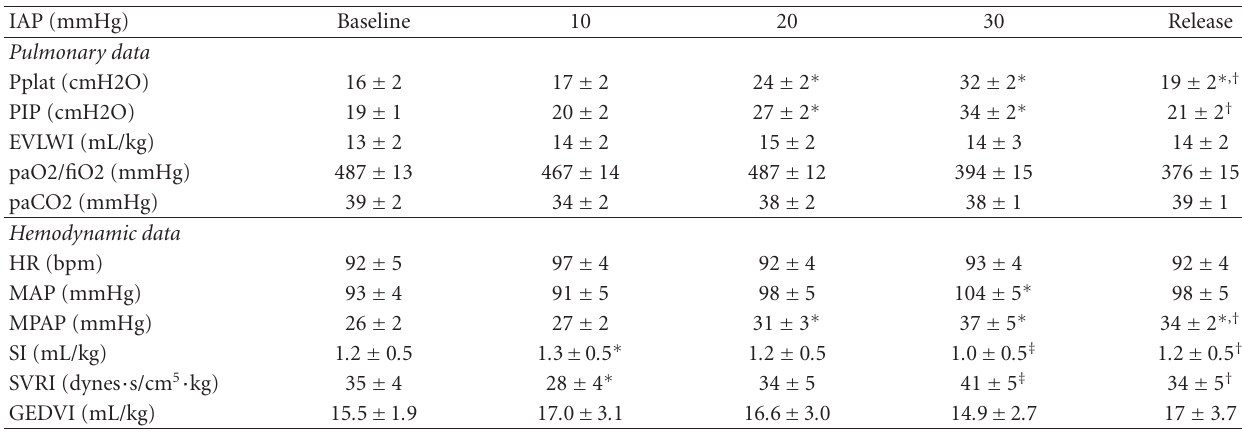
Table 1: E ff ect of increasing intra-abdominal pressure (IAP) on pulmonary mechanics, pulmonary function, and global hemodynamics. Pplat plateau airway pressure, PIP peak inspiratory pressure, EVLWI extravascular lung water index, HR heart rate, MAP mean arterial pressure, MPAP mean pulmonary arterial pressure, SI stroke index, SVRI systemic vascular resistance index, and GEDVI global end-diastolic volume index. Data are expressed as mean ±